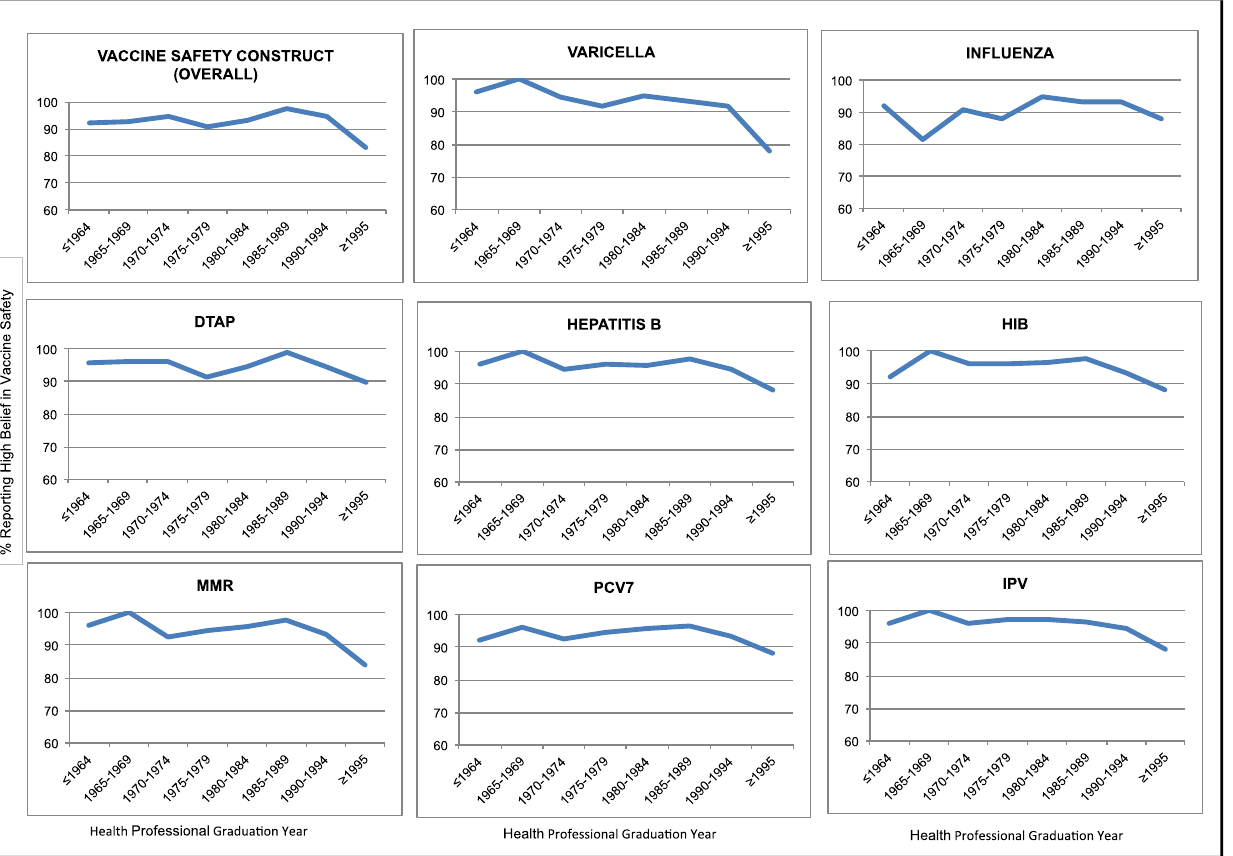
Figure 2. Percentage of providers reporting high belief in vaccine safety by year of health professional